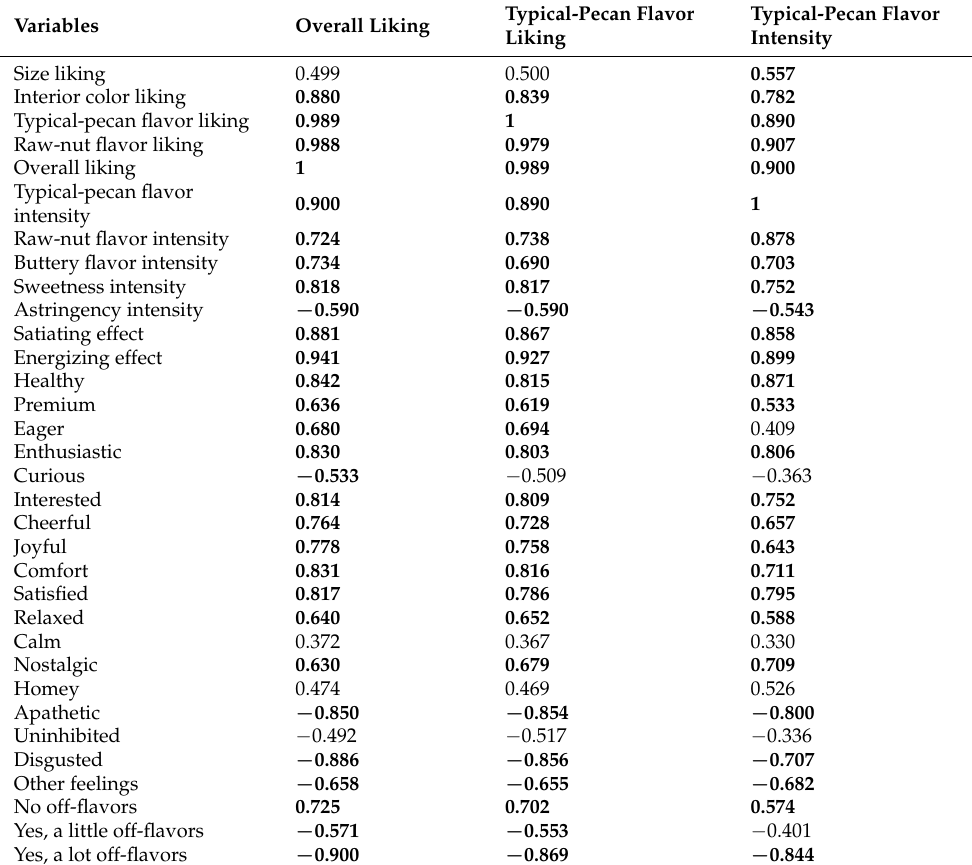
Table 4. Pearson correlation coefficient ( r ) between overall impressions (overall acceptance, typical- pecan flavor liking, and intensity) and all 33 variables in a significant level of p ≤ 0.05. Variables Overall Liking